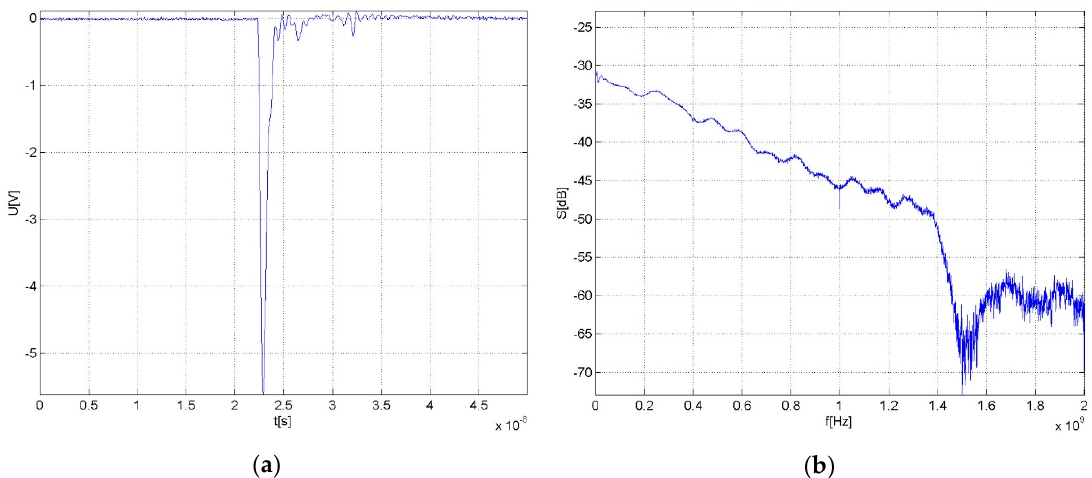
Figure 16. The waveform of the PD simulating impulse signal ( a ); the magnitude spectrum of the simulating signal ( b ).